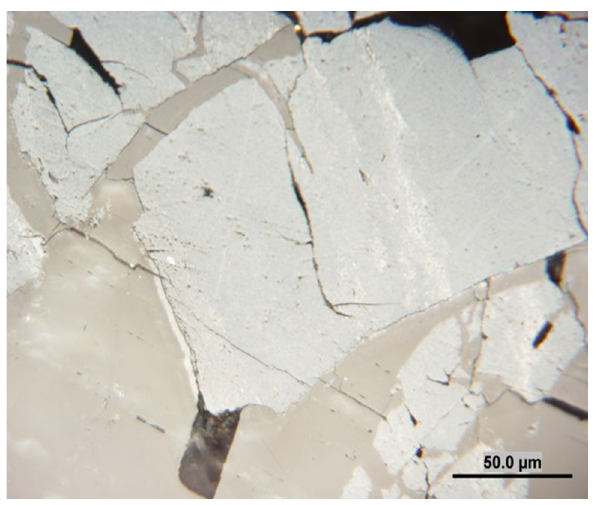
Fig. 6 Low altered vitrinite with micrinite, faulted by carbonate- filled cracks